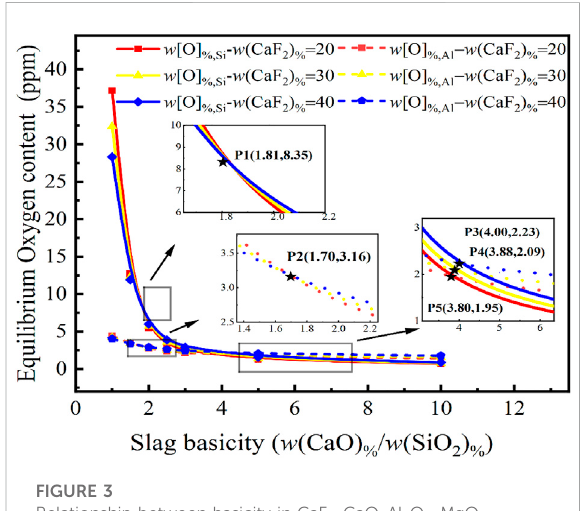
FIGURE 3 Relationship between basicity in CaF 2 -CaO-Al 2 O 3 -MgO- SiO 2 slag and CaF 2 content on the equilibrium oxygen content at 1,873 K for a certain molten steel composition { w [Si]% = 5.0, w [Al]% =